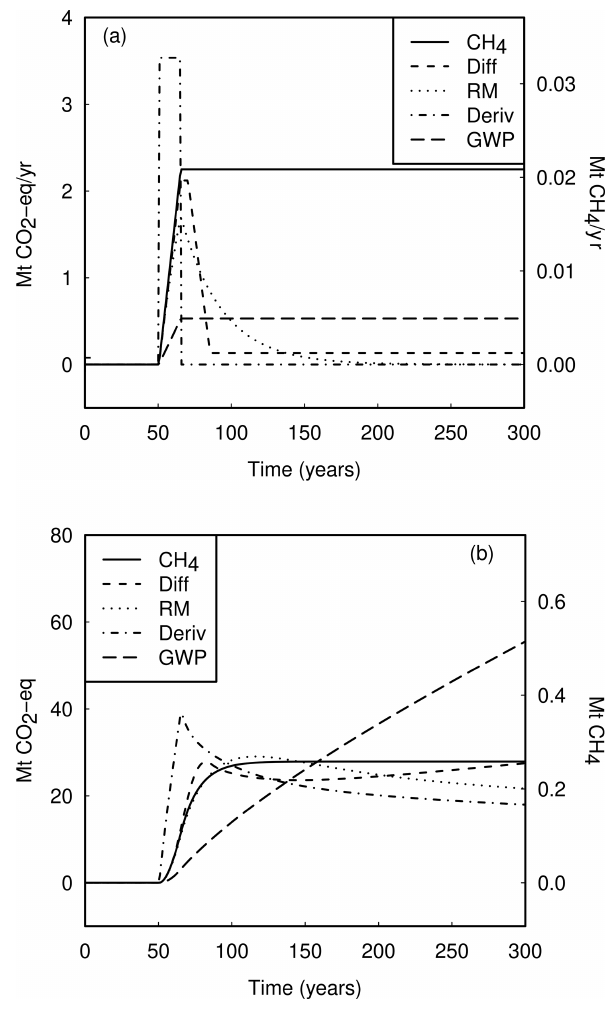
Figure 2. (a) A CH 4 source representing an increase over 15 years from zero to a constant (solid line) and the CO 2 -equivalent sources as defined by the various metrics described in Sect. 3. The rela- tive scaling of the CH 4 and CO 2 axes is a CH centrations from the source shown in panel (a) (solid line) and the CO 2 concentrations resulting from the CO 2 concentrations result- ing from the equivalent CO 2 sources, as shown in panel (a) . The relative scaling of the axes is a CH ing can be compared